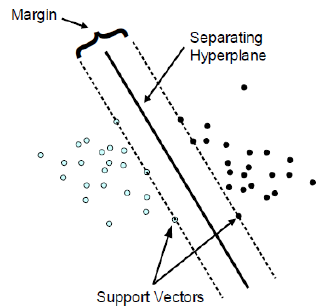
Figure 3. Classification using support vectors and separating hyperplane (Meyer, 2001). Hollow and solid dots represent two classes in feature space.